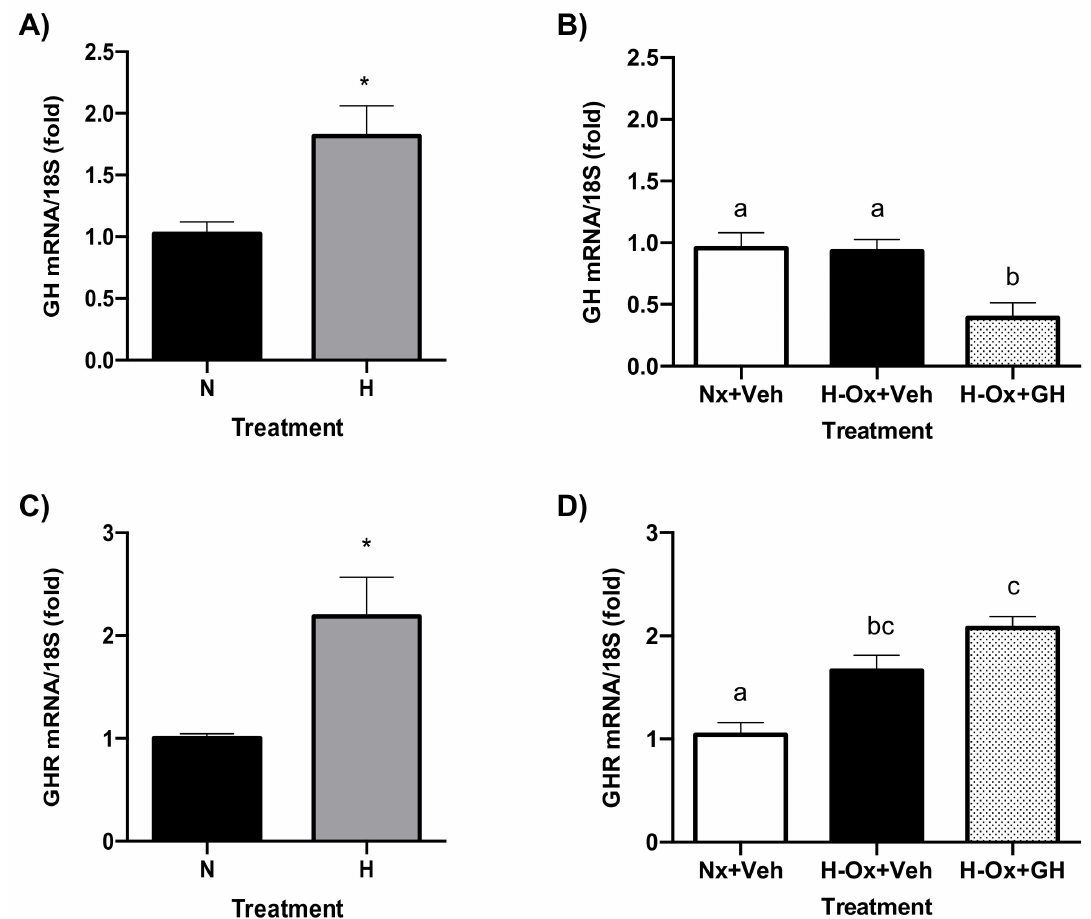
Figure 9. Effects of hypoxia and GH treatment upon the local expression of GH and GHR mRNAs in the embryonic chicken cerebellum. The relative expression of GH ( A ) or GHR ( C ) mRNAs was determined by qPCR after 24 h of hypoxia, or after reoxygenation for another 24 h with or without GH treatment ( B , D ). Ribosomal 18S RNA was used as housekeeping gene control. Bars represent the mean ± SEM, n = 5 independent experiments by duplicate. Groups with different letters are signifi- cantly different by one-way ANOVA and Tukey’s post hoc test. Asterisk (*) represents differences by Student ´ s t test ( p <